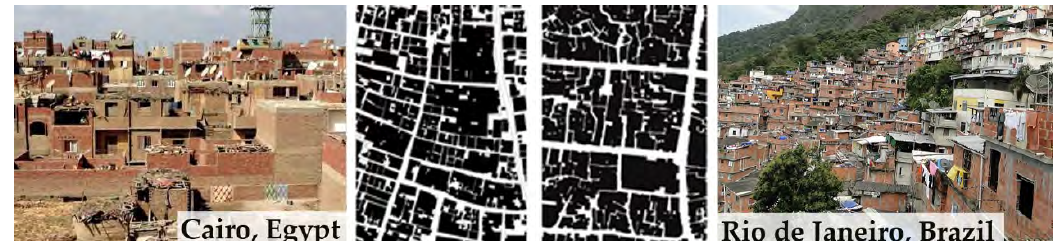
Figure 1. Examples of the permanent buildings type of UPAs from Cairo, Egypt and Rio de Janeiro, Brazil. Notice the similarity in the urban tissue and buildings type. Source: google earth maps edited by the